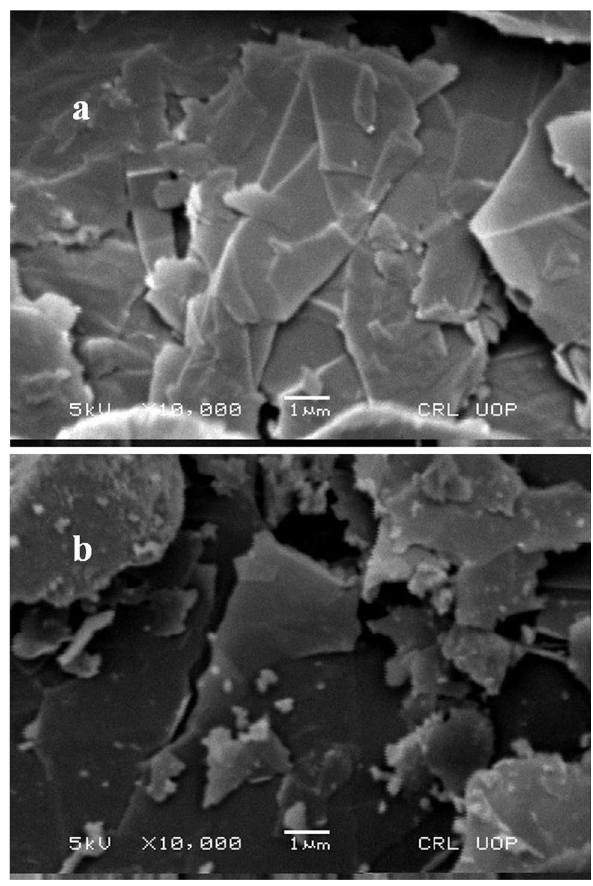
Fig. 1 SEM micrographs of a GNP and b TiO